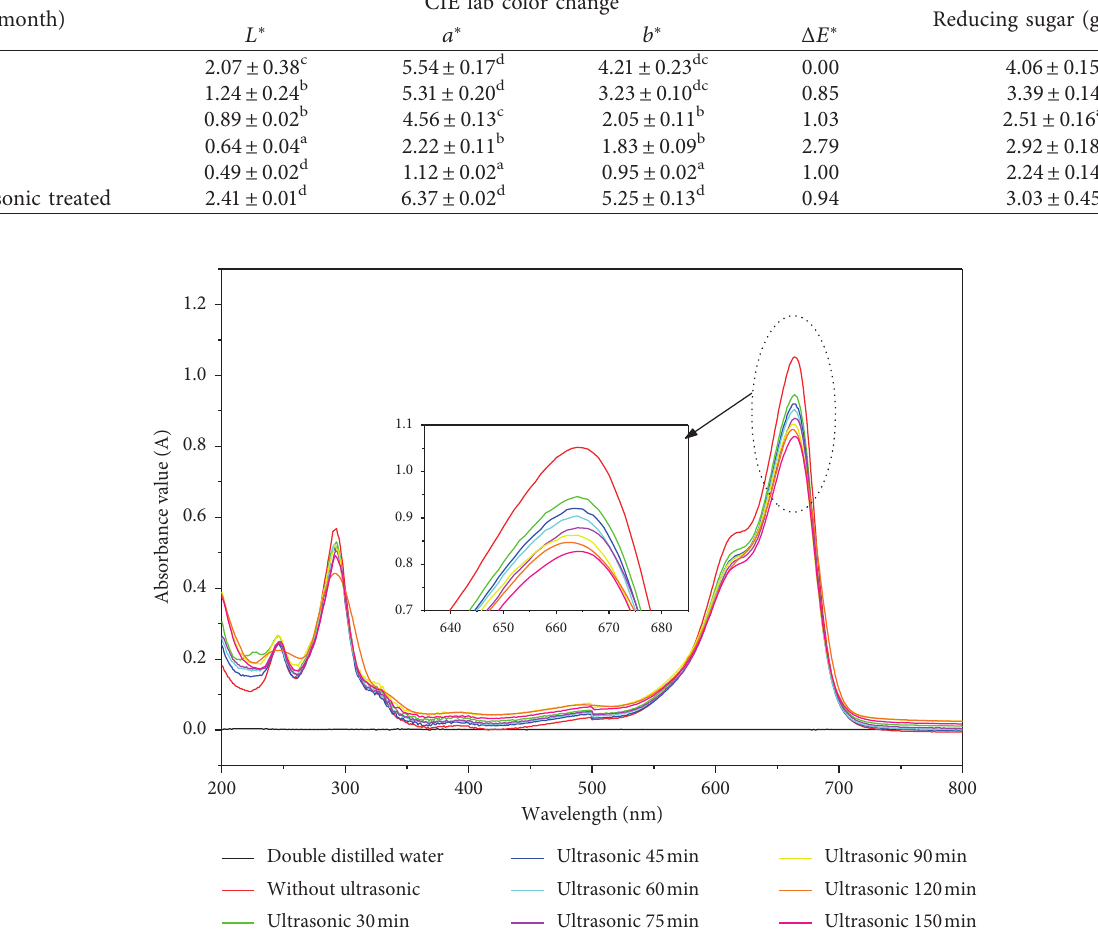
Table 1: Effect of color change and reducing sugar in the natural ageing process of vinegar and ultrasound treated vinegar. Age (month)